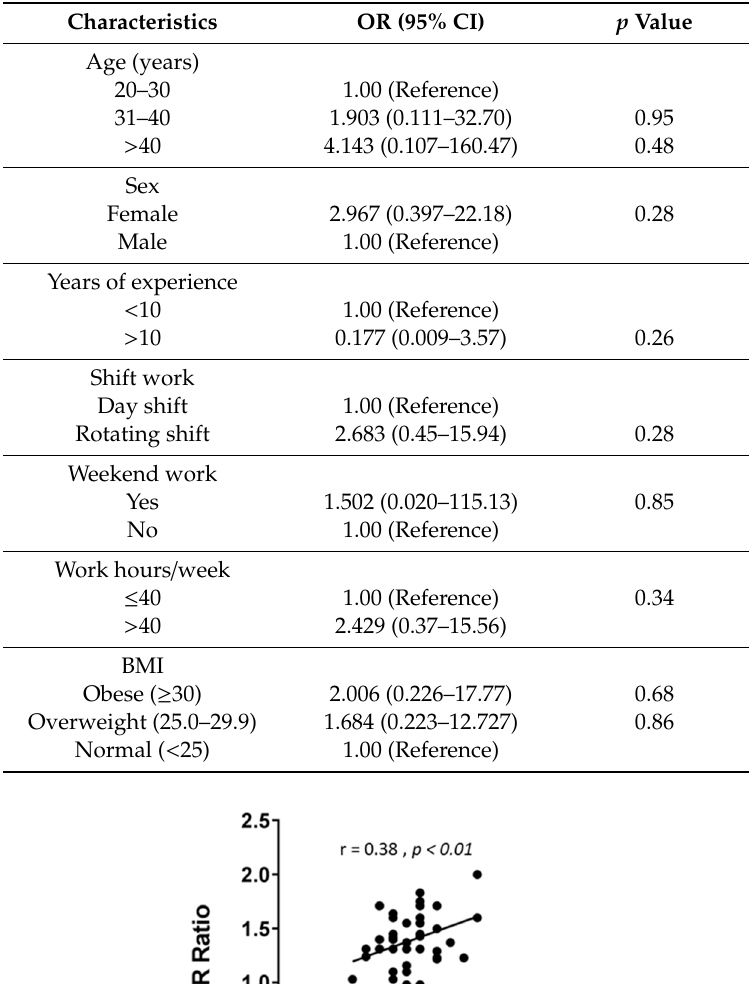
Table 7. Demographic and socioeconomic indicators as risk factors for high OC.